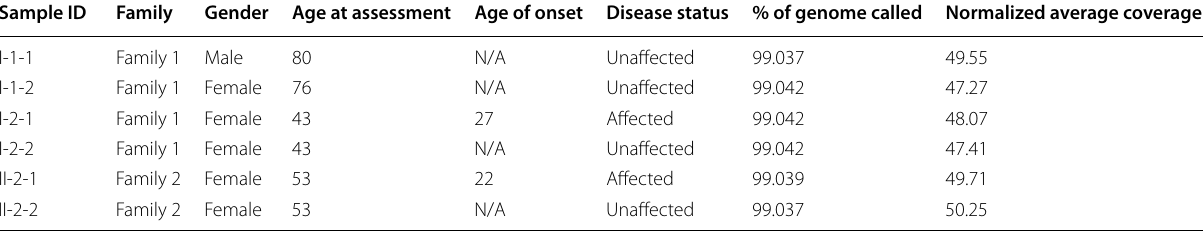
Table 1 Identity of sequenced genomes Sample